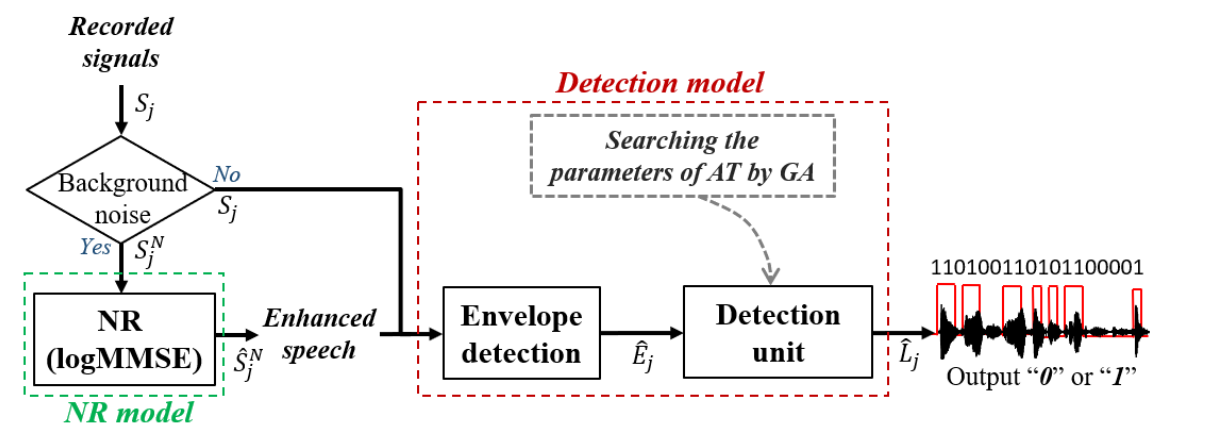
Figure 1. Proposed automatic speech detection system. AT: adaptive threshold; GA: genetic algorithm; logMMSE: logarithm minimum mean square error; NR: noise reduction.